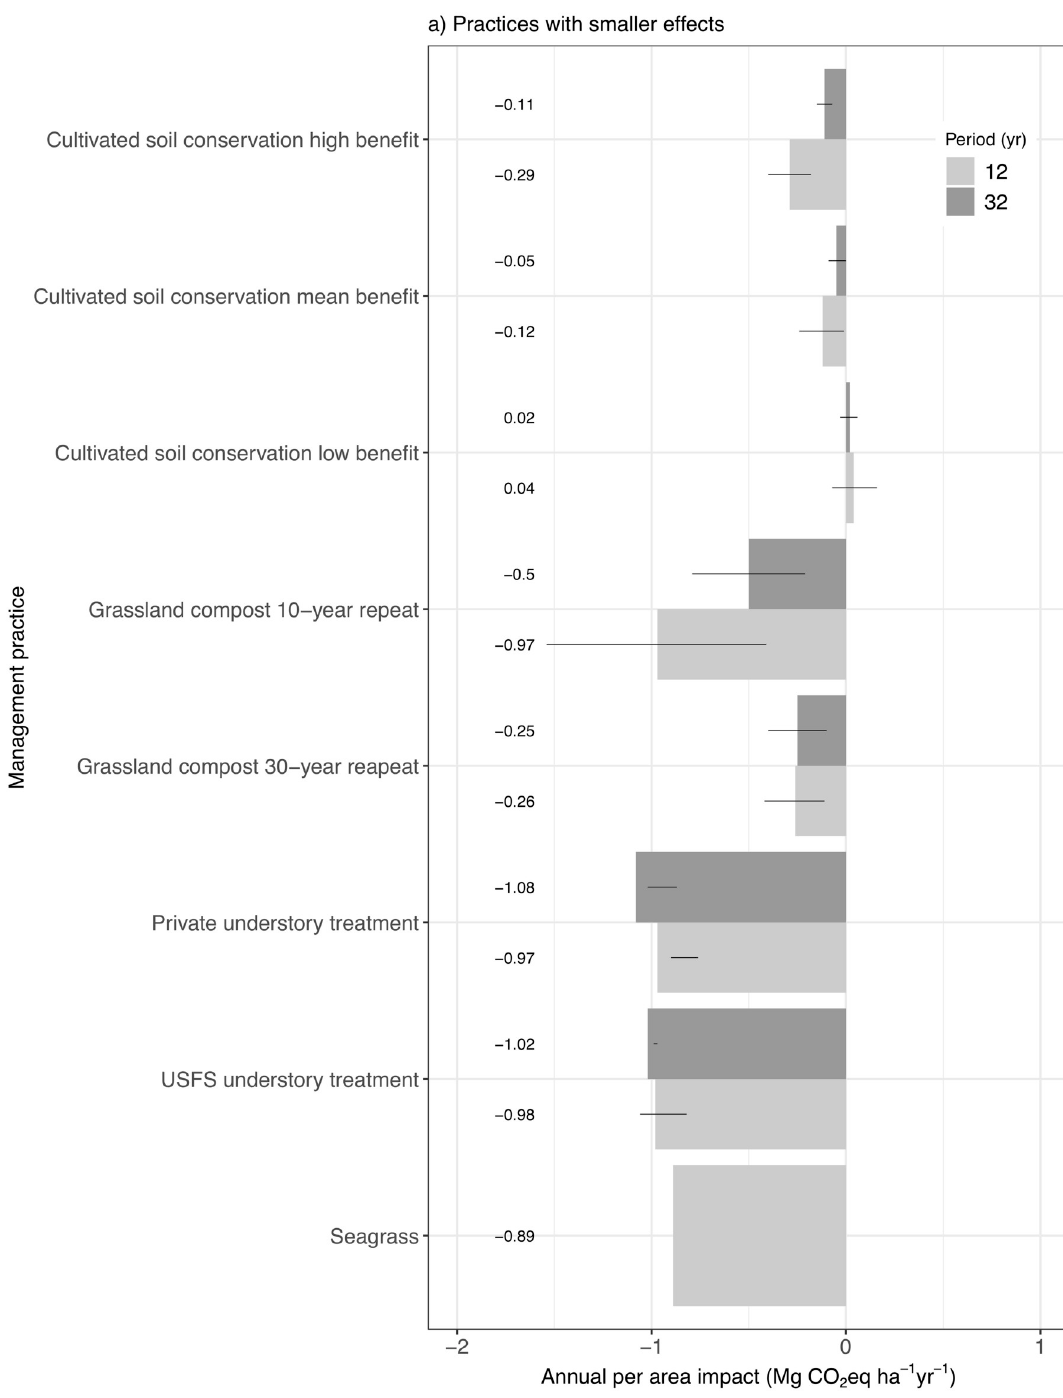
Fig 7. Annual per-area effects of individual practices in isolation, based on either 12 years of continuous implementation or 32 years of continuous implementation. Practices with smaller effects. Negative values represent reduced emissions, and the mean case values shown by the bars are listed. The lines designate the uncertainty limits based on low and high emission cases as determined by input carbon values. These values are calculated by dividing the cumulative benefit by the product of the cumulative implementation area and the number of implementation